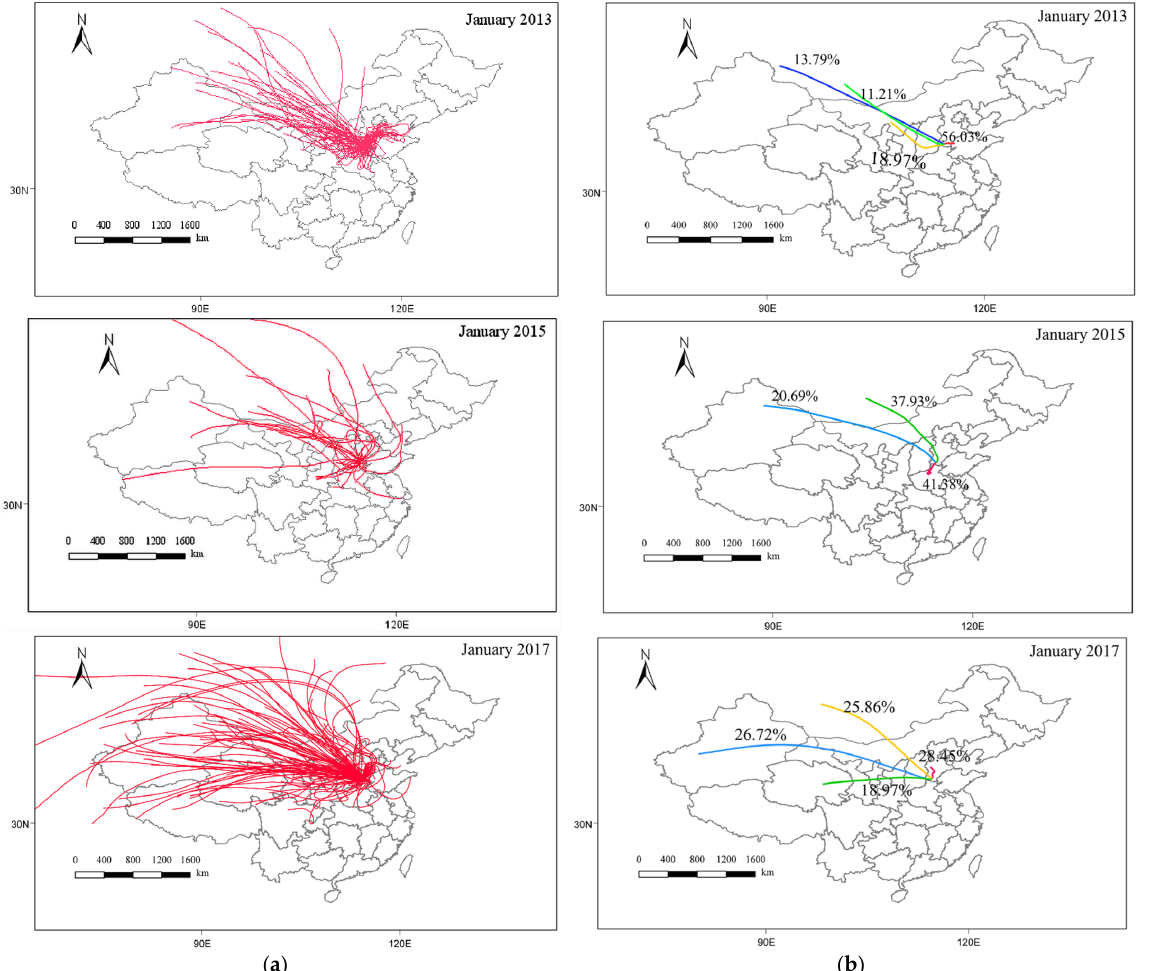
Figure 10. ( a ) The 72-h air mass HYSPLIT back trajectories; ( b ) trajectory cluster for January 2013, January 2015, and January 2017 at the sampling site.